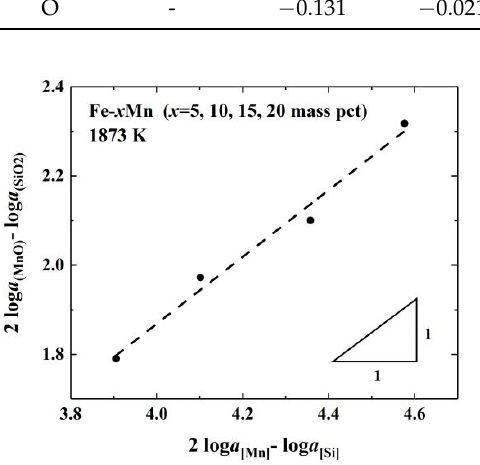
) as a function of log ( a 2 / a ( SiO / a [ Si ] ) in Fe-xMn melts aa in Fe-xMn ( MnO ) [ Mn ] 2 ) ]Mn[